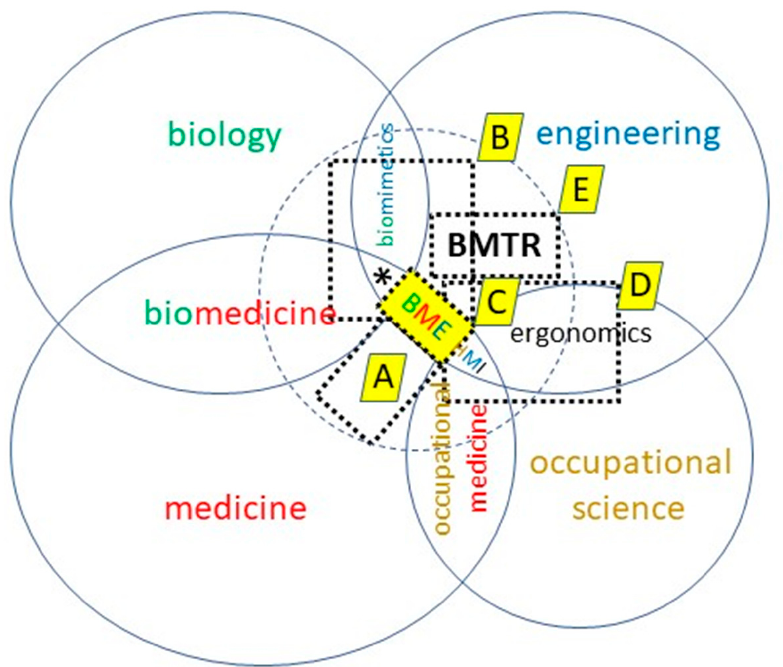
Figure 3. Overlay on Figure 1: Superimposed are the modules of the master’s study programs in which the associated content is taught. “A”—Anatomy and Physiology; “B”—Bio-oriented Methods in Engineering; “C”—Basics of Biomedical Engineering; “D”—Human-Serving Systems; “E”—Biomechatronics. Asterisk * : engineering for biology (“E4B”).